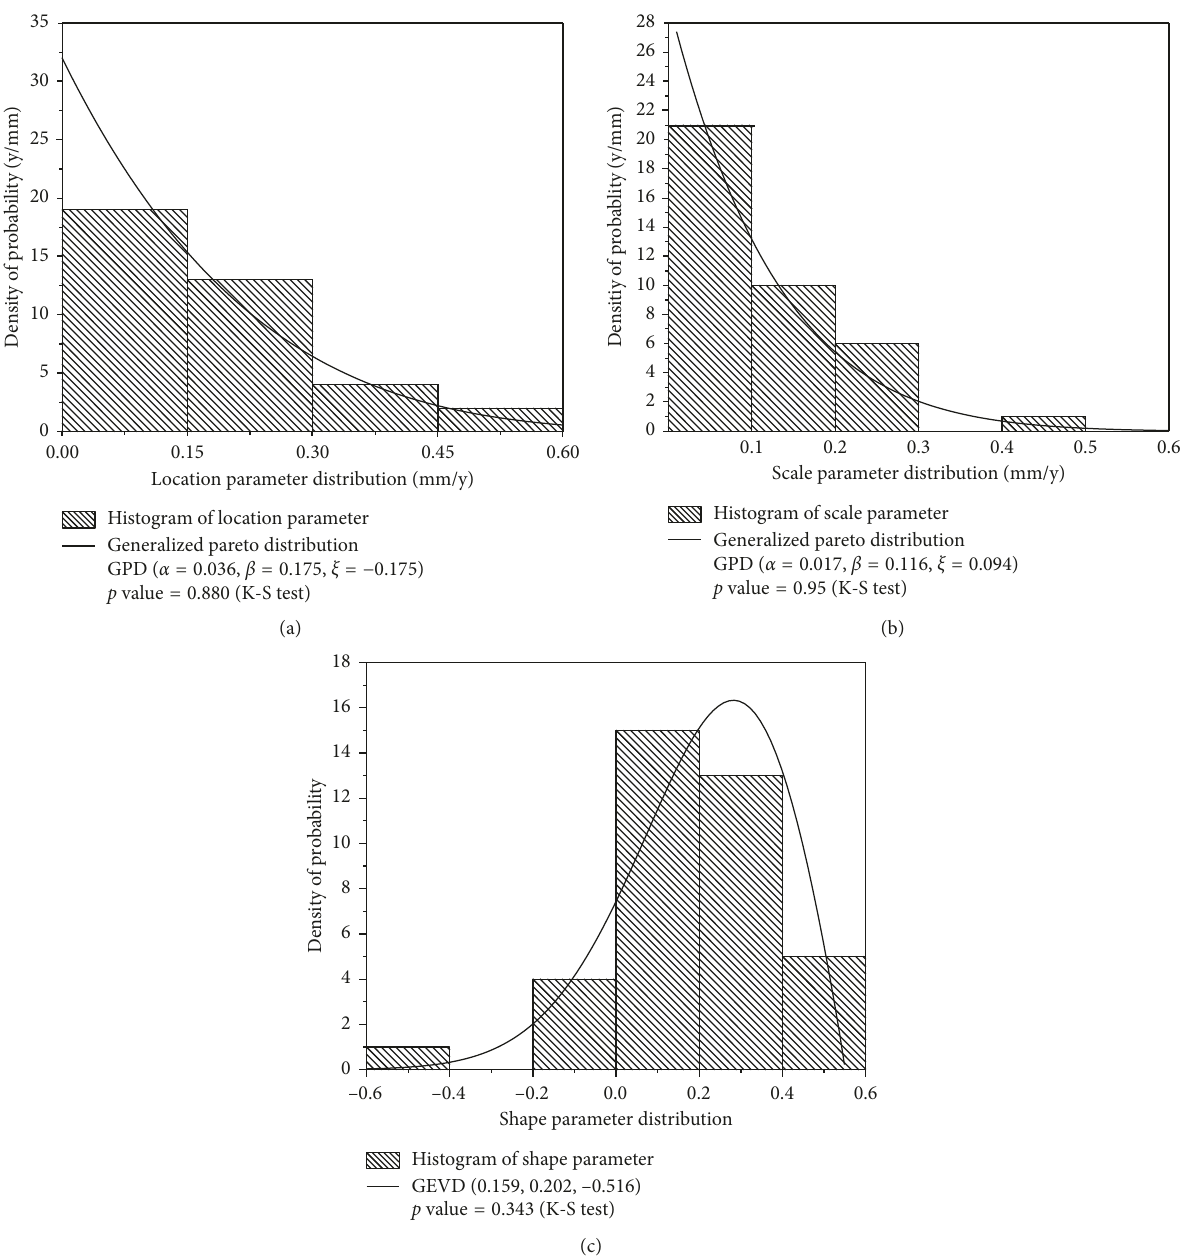
Figure 3: Parameter Distribution for (a) Location, (b) Scale, and (c) Shape parameters of the GEV model for wall thickness thinning rate in heat exchangers (all the Probability Density Function (PDF) values plotted in this paper were adjusted in order for the distribution to “look like” the histogram. To do this, it is necessary to convert the PDF to the histogram’s size using the bins’ width and the number of bins. Reference [44] explains this process in